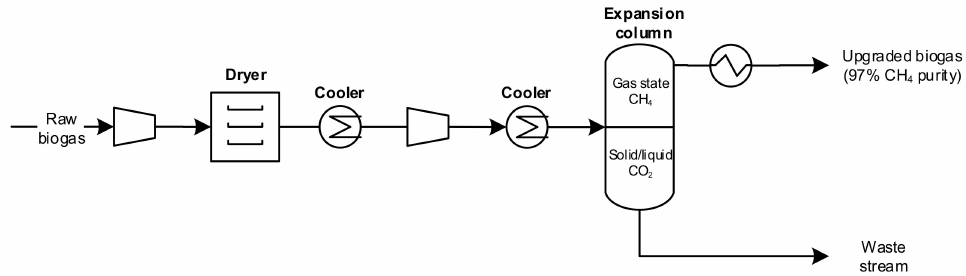
Figure 10. Simplified diagram of cryogenic separation. Adapted from Muñoz et al.